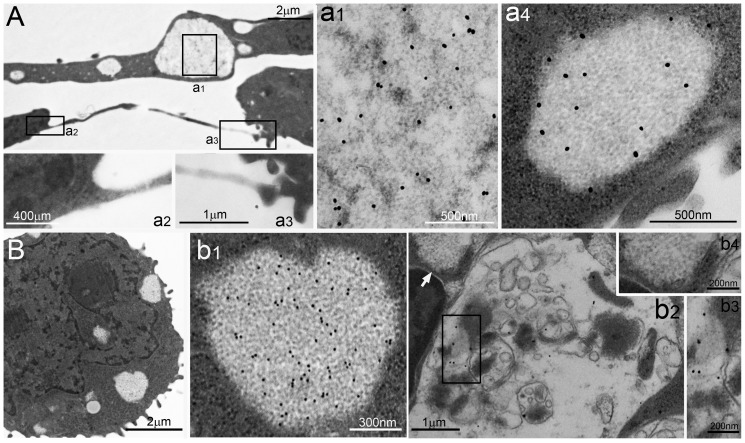
PaCSs in SH-SY5Y and HL-60 cells.(A) Ultrastructure of a neuroblastoma SH-SY5Y cell with characteristic PaCSs, enlarged (a1) to show relatively spaced particles and selective FK1 antibody immunogold. In (A) a neural cell process whose hillock-like origin and terminal button abutted on another cell is enlarged in (a2) and (a3), respectively. In (a4) a 20S proteasome-reactive PaCS from a different SH-SY5Y cell is filled with particles and surrounded by ribosomes. (B) Several PaCSs in an HL-60 cell; one of which (b1) shows FK1 immunogold; in (b2) ALFY reactivity of an autophagic vesicle, enlarged in (b3), and non-reactivity of a small PaCS (arrow), enlarged in (b4).